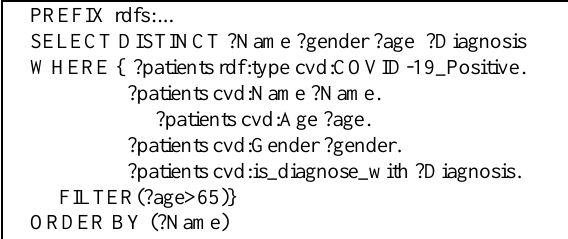
Figure 5. SPARQL Query for COVID-19 positive cases who